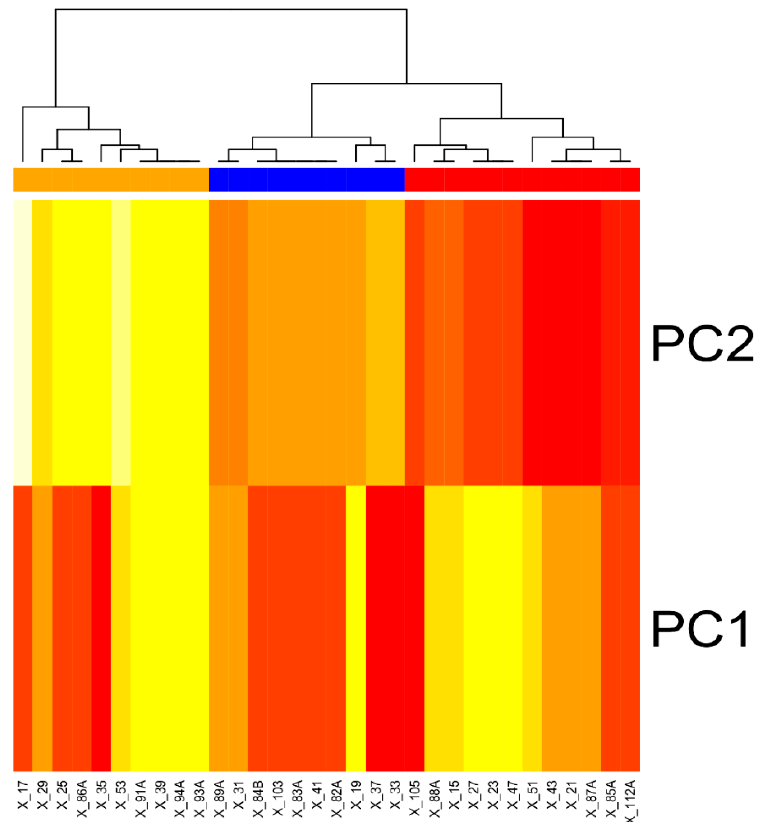
Figure 2. Unsupervised integrative clustering (UIC) based on the expression of Mal d 1.06A , Mal d 1 protein concentration, and immunoreactivity of patients’ sera with apple extracts. Sample names are listed in Table 5.